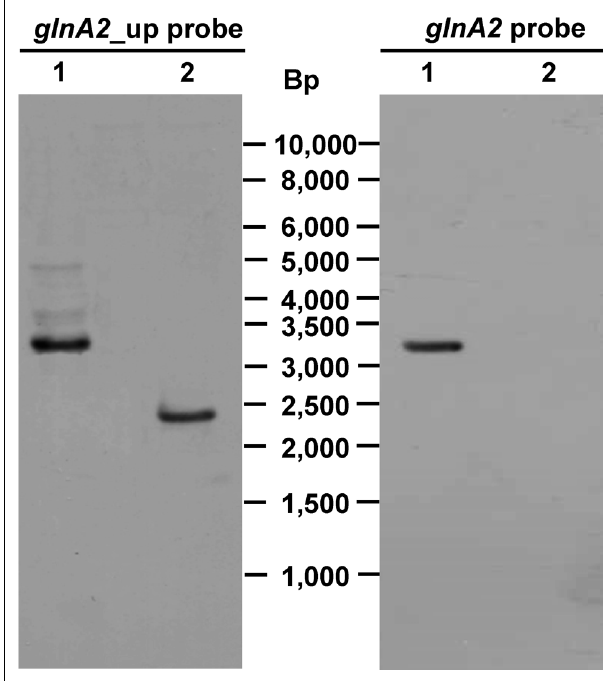
FIGURE 3 | Genotype of Halobacillus halophilus (cid:2) glnA2 . Pst I/ Bgl I digested genomic DNA from Halobacillus halophilus wild type (lane 1) or Halobacillus halophilus (cid:2) glnA2 (lane 2) was separated by gel electrophoresis, transferred to a nylon membrane and probed with specific DIG-labeled DNA fragments against one flanking region of the mutated glnA2 or the glnA2 gene. Numbers in the middle indicate the migration positions of standard DNA fragments.